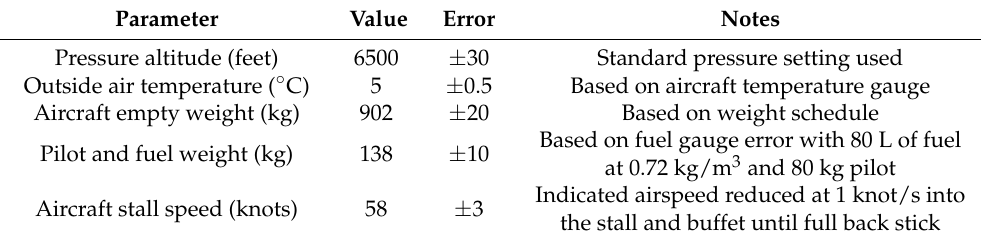
Table 1. Summary of flight test conditions for the tailplane stall